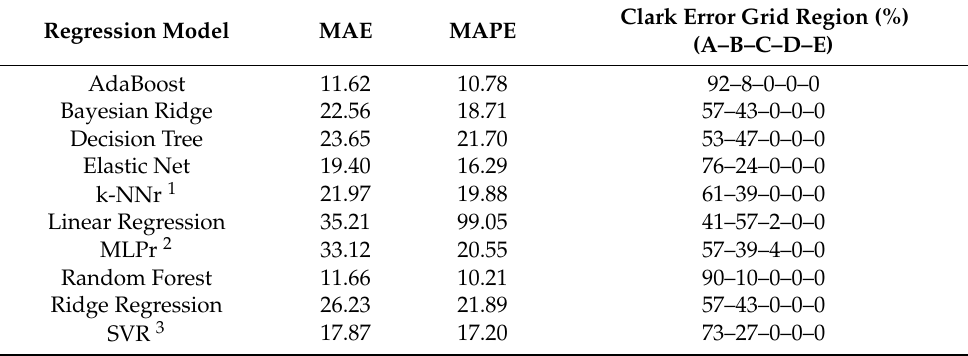
Table 3. Results on the test subset using the MFCC